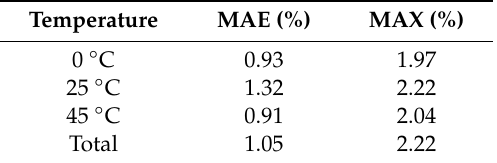
Figure 16. SOC estimation curves under high rate pulse discharge conditions: ( a ) 0 °C; ( b ) 25 °C; ( c ) 45 °C. Table 6. SOC estimation result under high rate pulse discharge conditions.